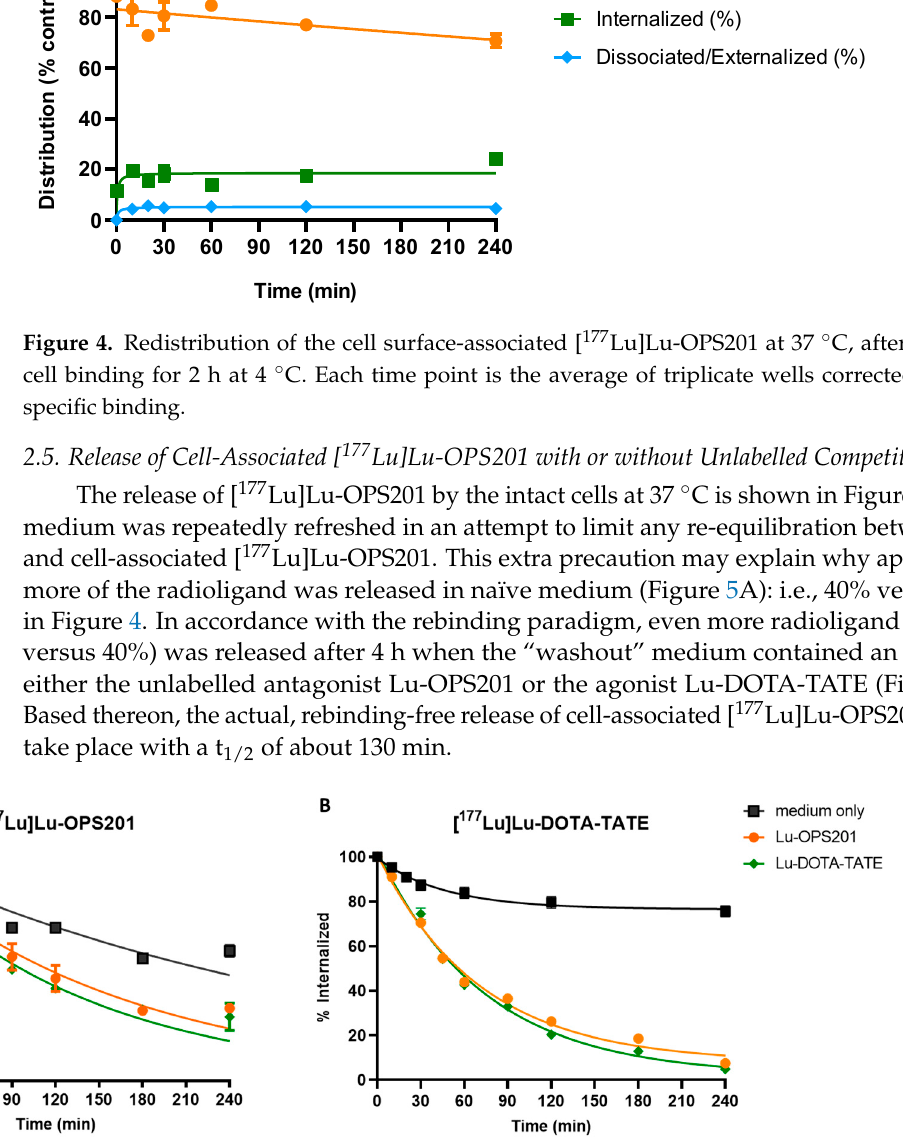
Figure 5. Dissociation/externalisation kinetics of [ 177 Lu]Lu-OPS201 ( A ) at 37 ◦ C, after allowing cell binding for 2 h at 4 ◦ C. Data are plotted as percentage of the cell-associated fraction (surface-bound and internalised fraction at the onset of the washout step). Externalisation kinetics of [ 177 Lu]Lu-DOTA-TATE ( B ) at 37 ◦ C, after allowing its internalisation for 2 h at 37 ◦ C. Data are plotted as percentage of the internalised fraction at the onset of the washout step.